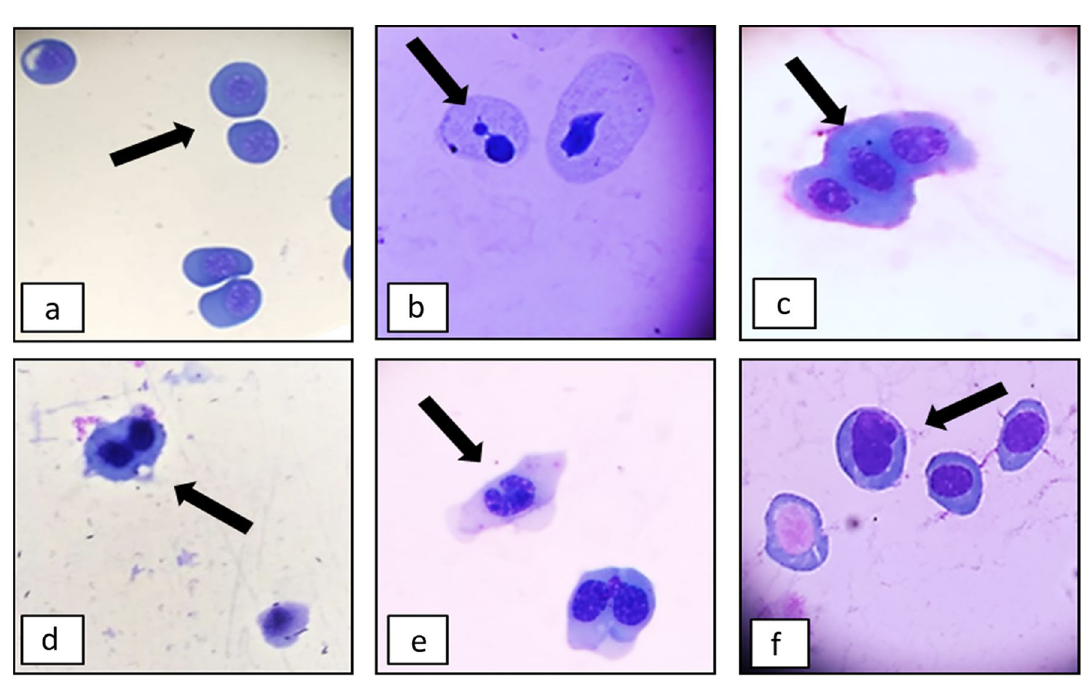
Figure 5. Erythrocyte Nuclear Abnormalities found in the tadpoles of Leptodactylus luctator and Physalaemus cuvieri exposed to different concentrations of imidacloprid for 168 h. ( a ) Normal cells, ( b ) Micronucleus (MN); ( c ) Nuclear bubble/bud (NB); ( d ) Binucleated cell (BC); ( e ) Notched nucleus (NN); ( f ) Lobed nucleus (LN). (For the color version of Fig. 5, the reader is referred to the web version of this